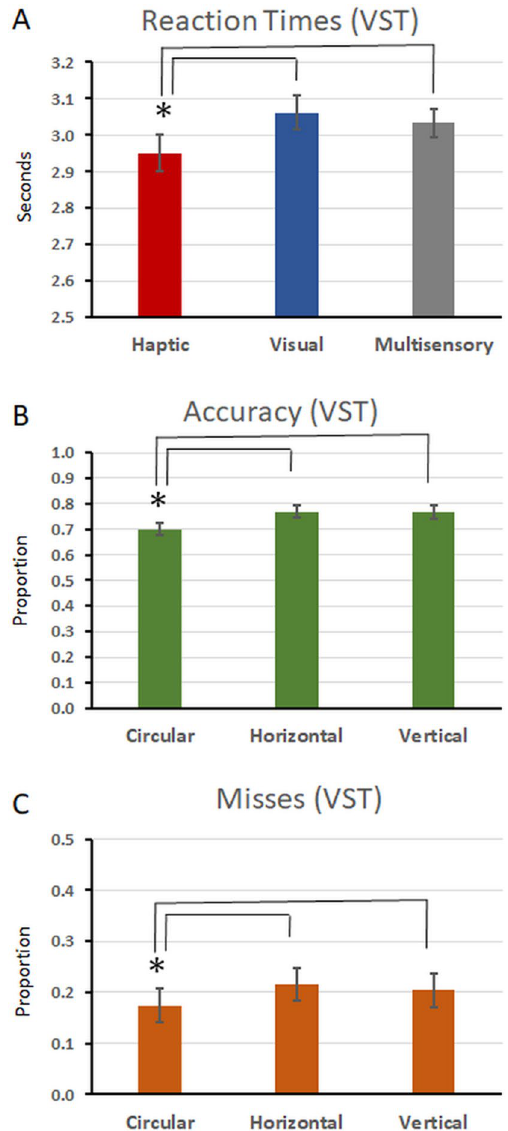
Figure 3. Group-averaged (N = 25) data from the VST task. ( A ) Displays the RT data collapsed across sliders. ( B ) Displays the accuracy data collapsed across modalities. ( C ) Displays the misses collapsed across modalities. In all panels, the error bars indicate the standard error of the mean. Asterisks indicate a significant difference (p < 0.05; Holm–Bonferroni